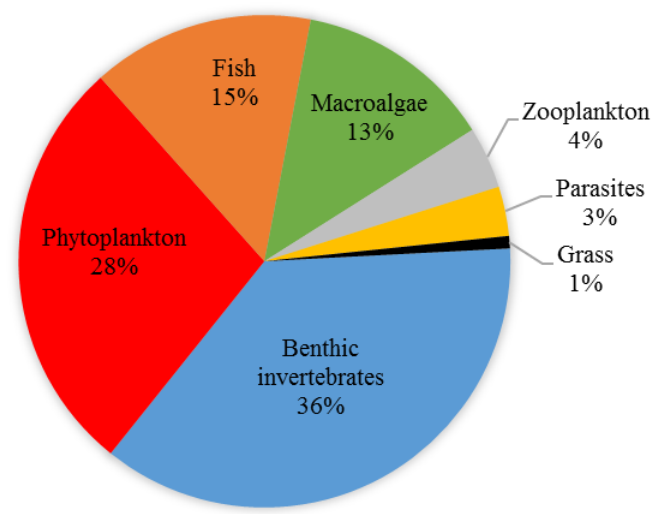
Figure 2. Distribution of functional groups of the 123 NIS recordings in Danish waters.